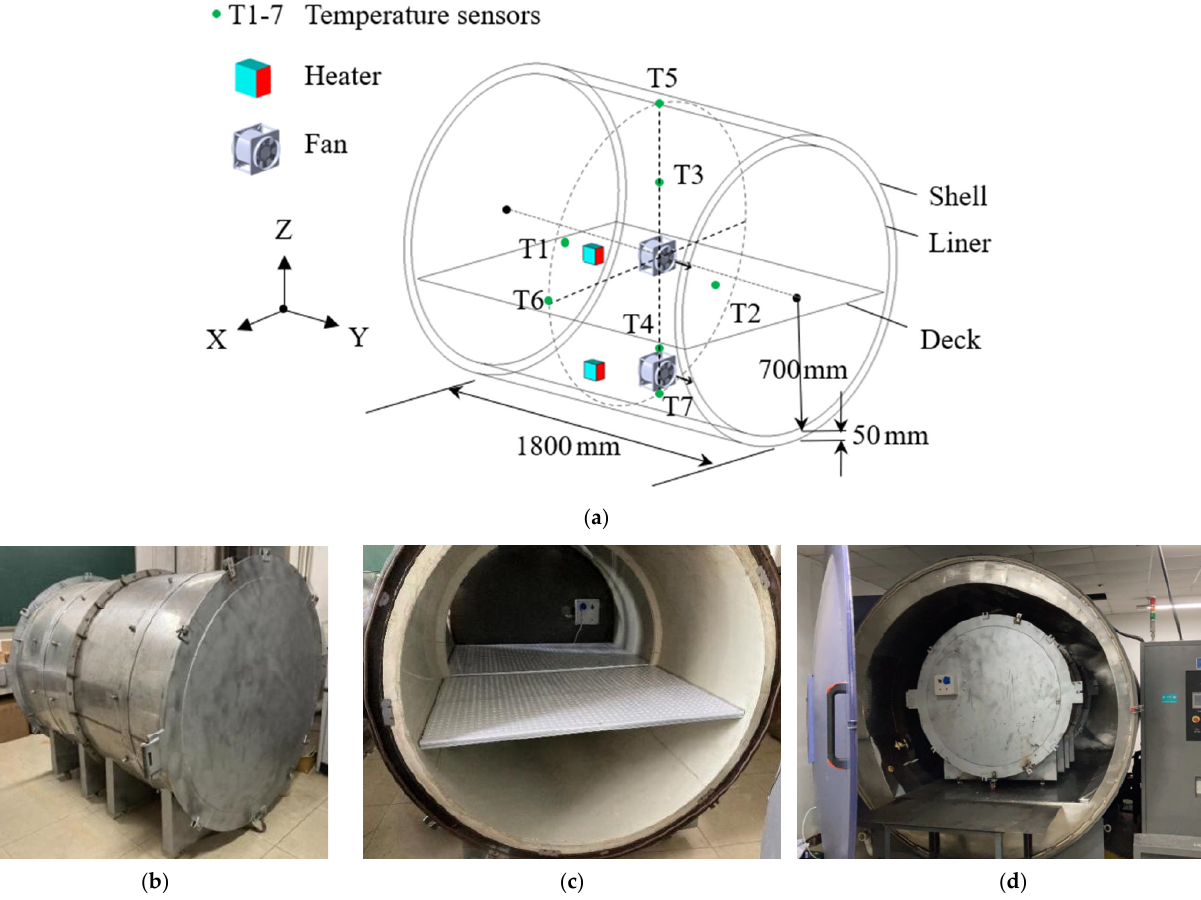
Figure 3. Reduced-scale aircraft-cabin mockup for model validation: ( a ) schematics, ( b ) cabin mockup, ( c ) inside view of cabin mockup, ( d ) cabin mockup inside an environmental chamber.